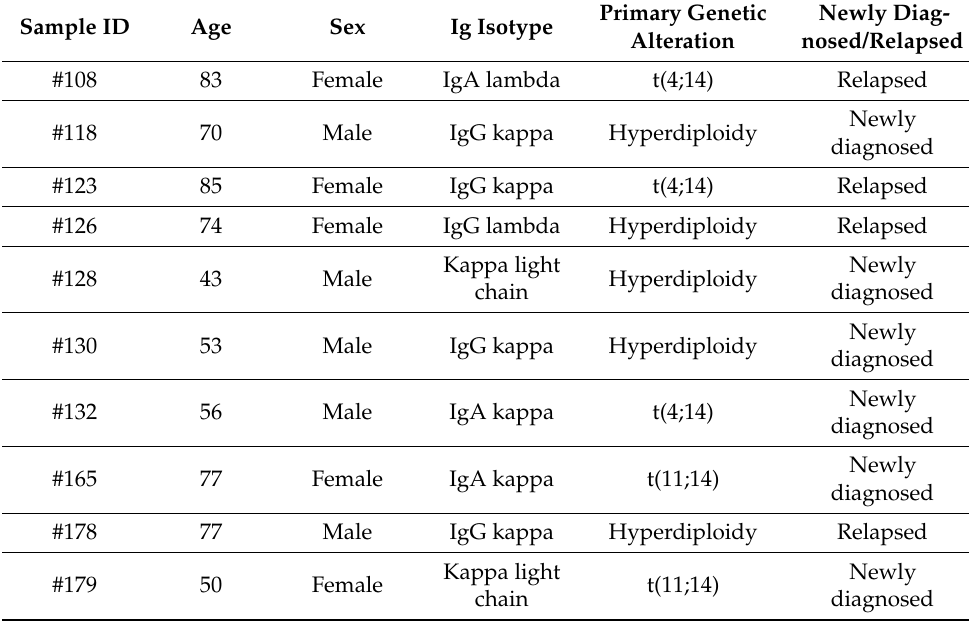
Table 1. Multiple myeloma patients with excellent in vitro growth potential of neoplastic plasma cells used in this study.